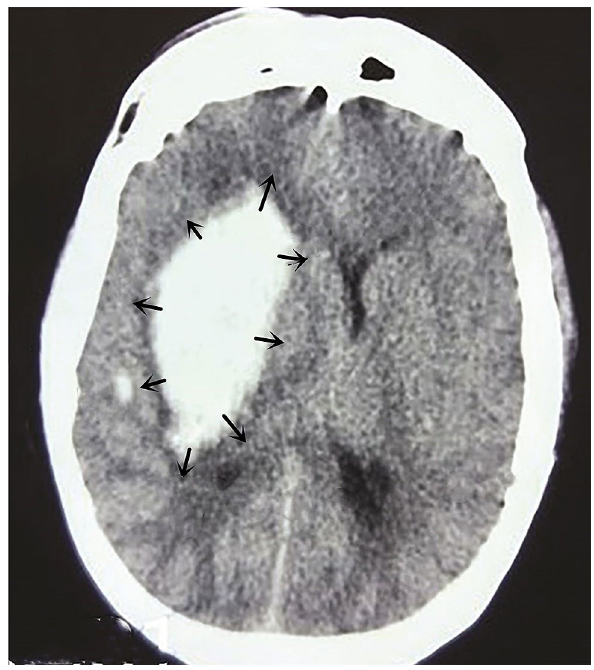
Figure 3. The space occupying effect of cerebral hemorrhage makes the pressure of the hematoma higher than that of the brain tissue and forces the surrounding brain tissue to shift until the pressure of the hematoma equals that of the brain tissue.